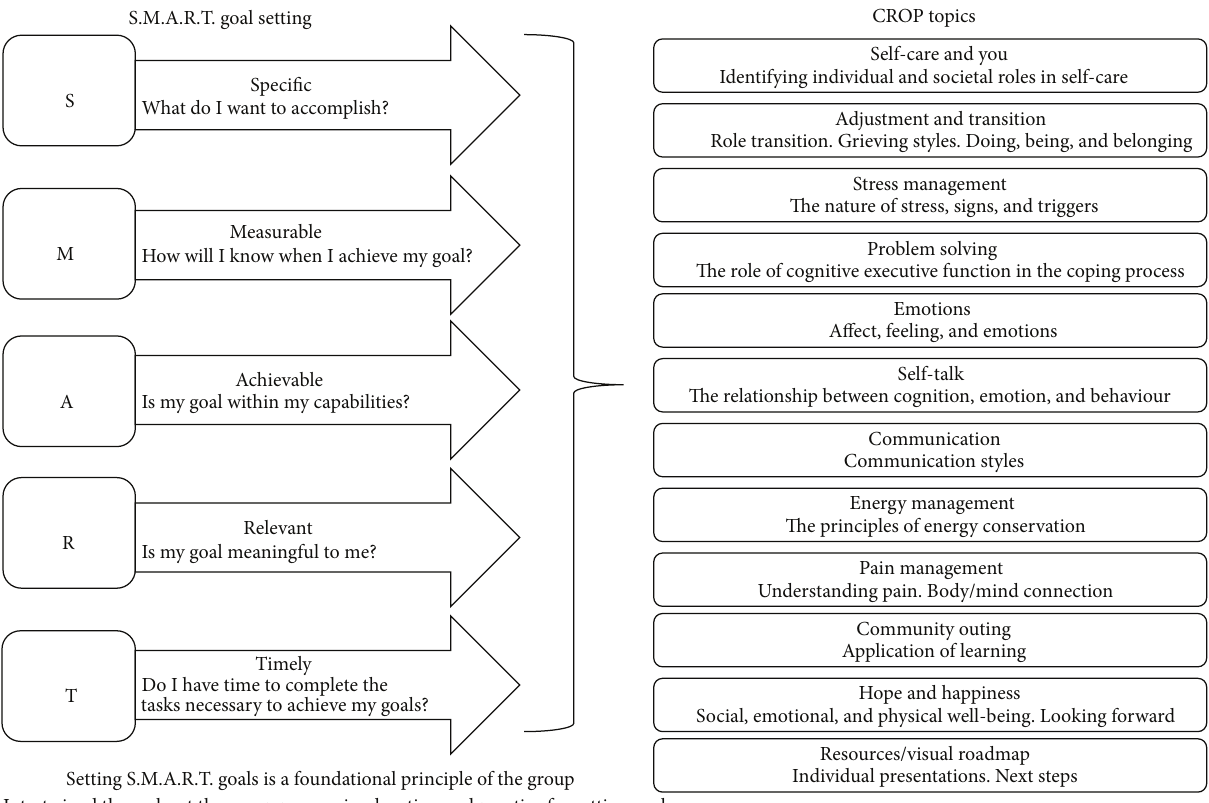
Figure 1: CROP S.M.A.R.T. goals and topics.